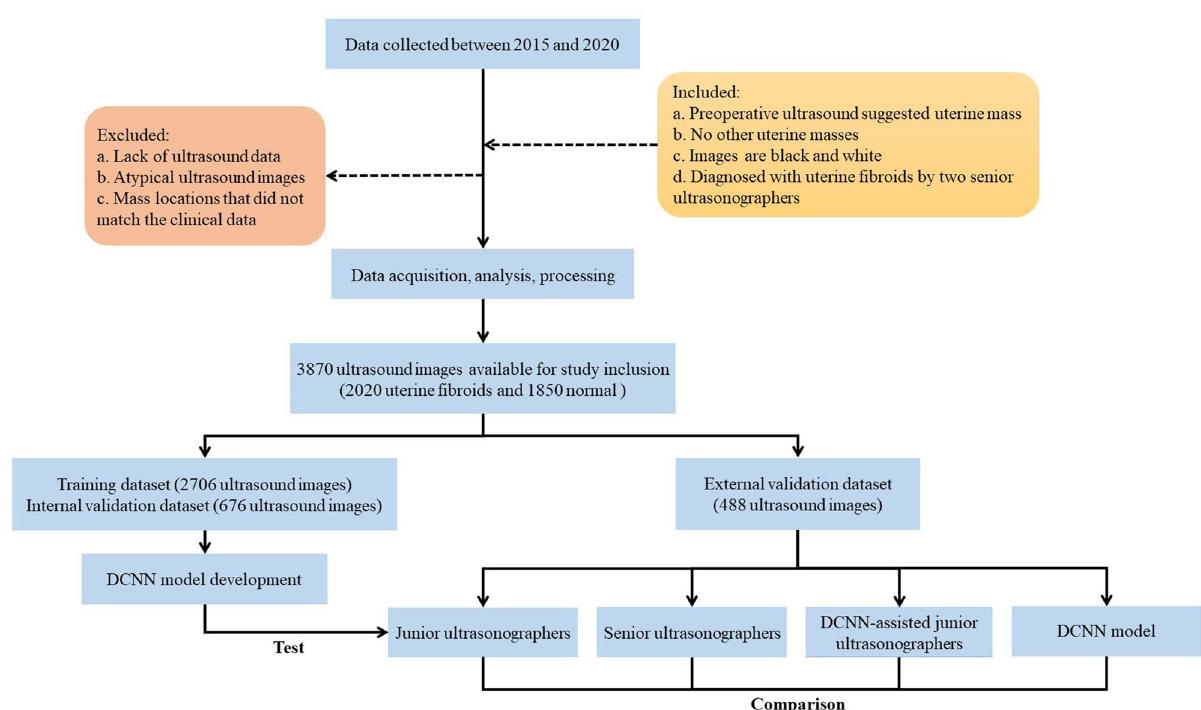
Figure 1. Flowchart of the procedures used in the development and evaluation of the DCNN model for automated uterine fibroid diagnosis. DCNN deep convolutional neural